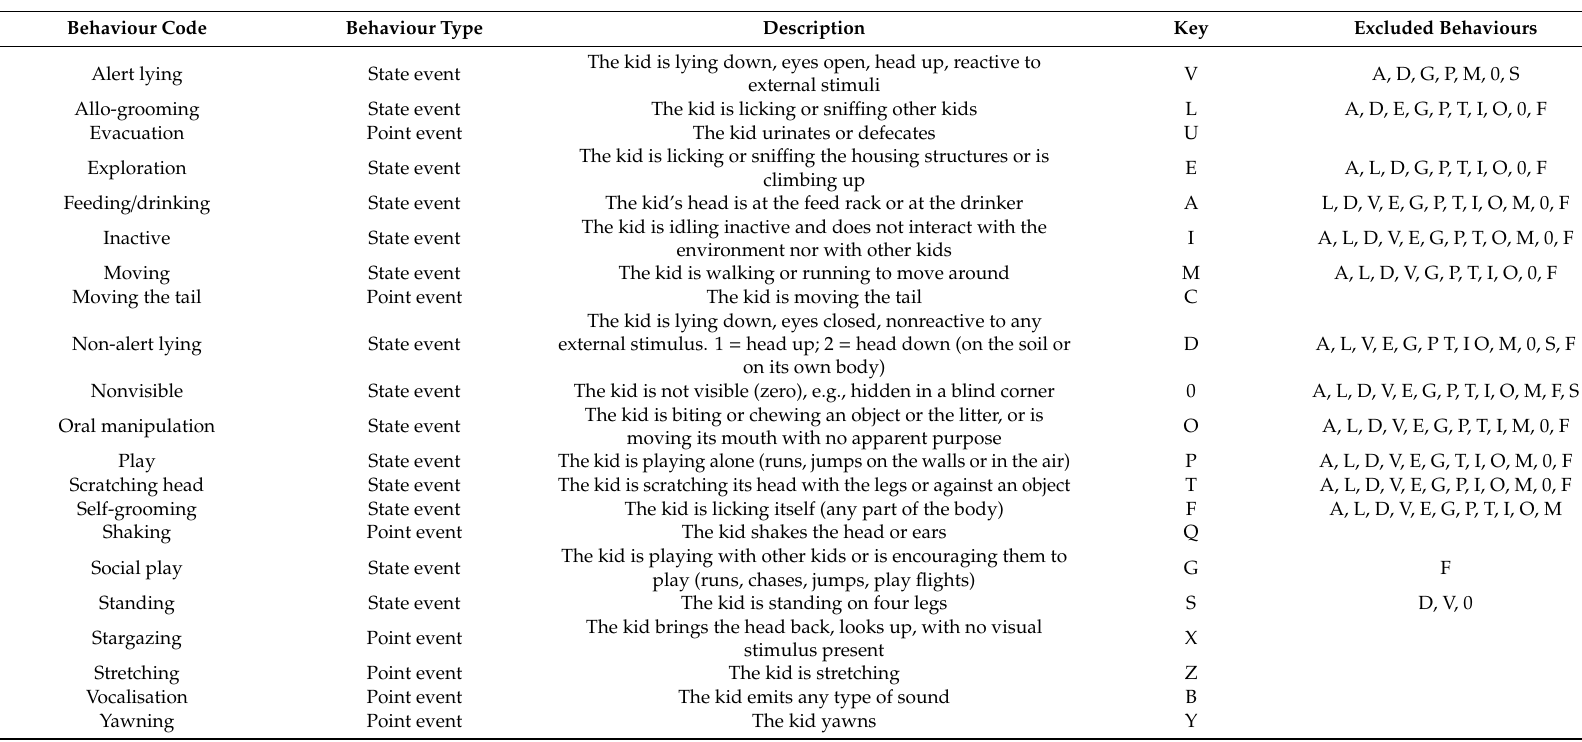
Table 1. List of behaviours (state or point events) monitored during the experiment and their definitions and codes. Mutually exclusive behaviours are reported in the column “Excluded